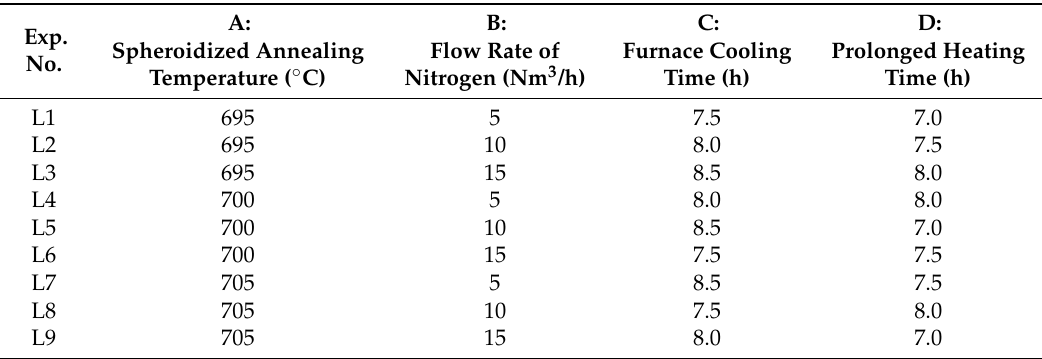
Table 3. L 9 (3 4 ) orthogonal array experimental parameter